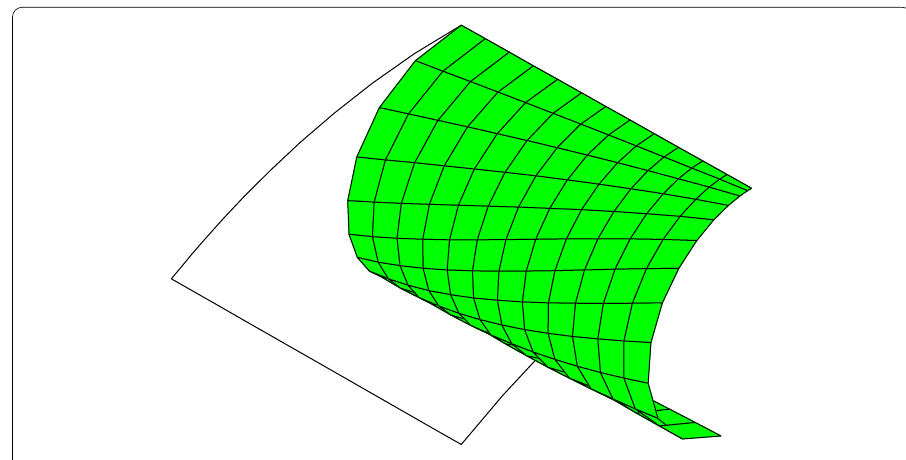
Fig. 15 Cylindrical shell segment: deformed distorted mesh for M 0 = 4 · 10 4